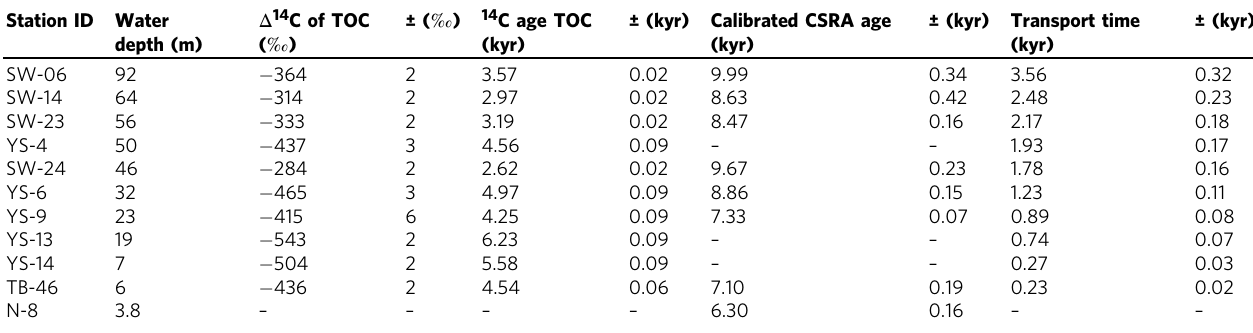
Table 1 Radiocarbon data for bulk organic carbon and long-chain fatty acids as well as the deduced transport times for stations along the Laptev Sea transect Station ID Water depth (m)